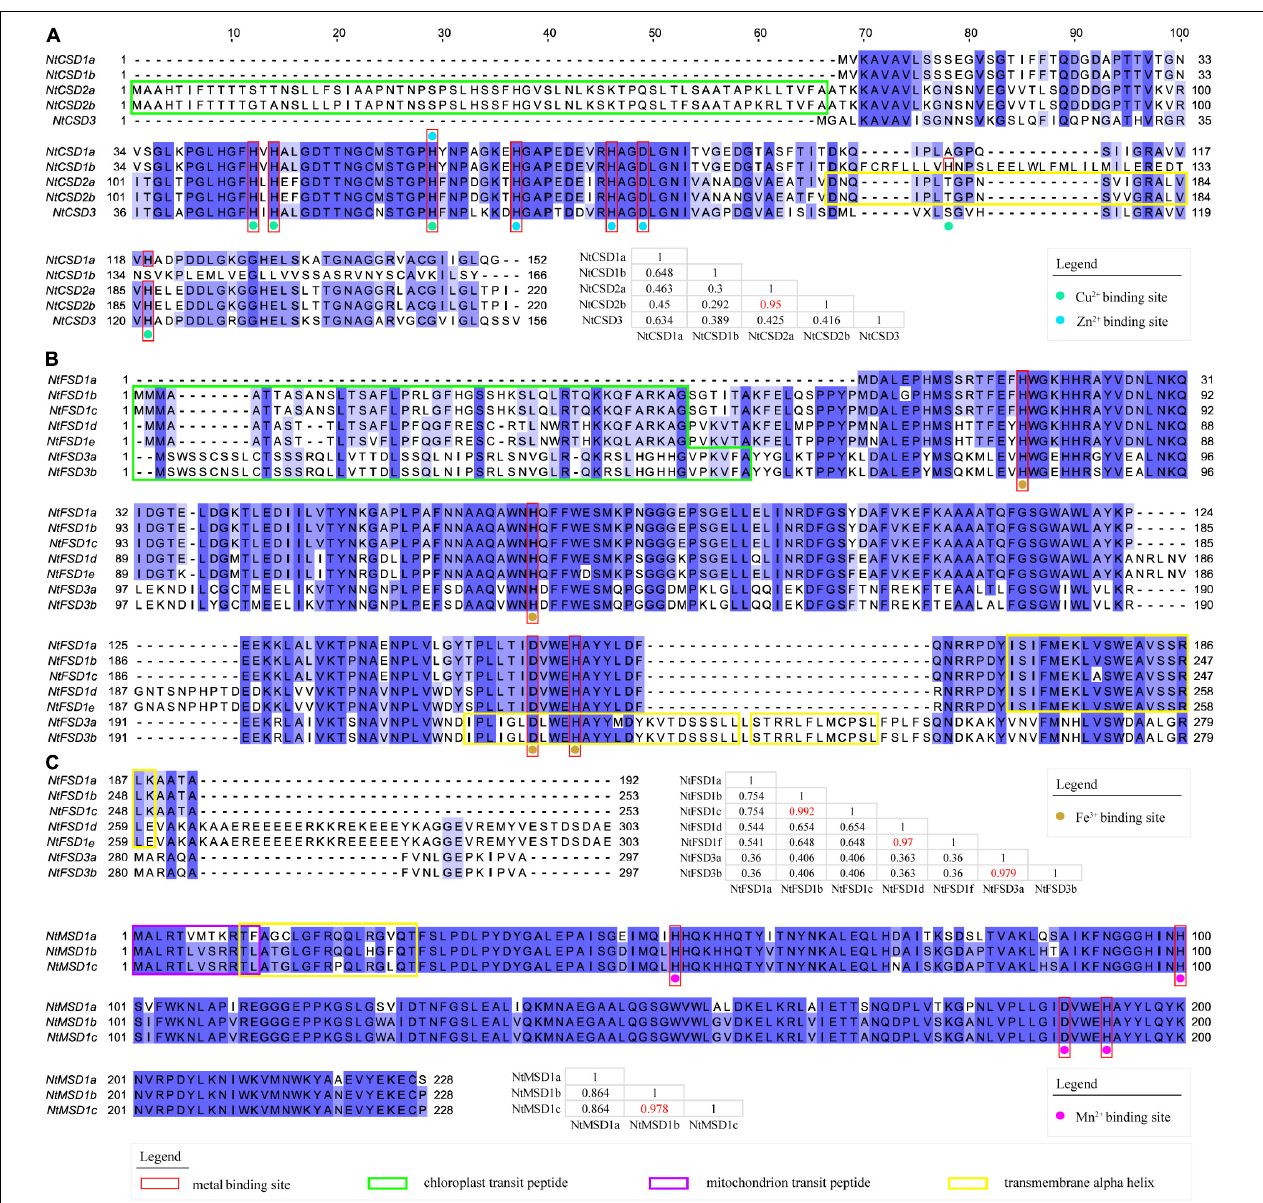
FIGURE 2 | Multiple sequence alignment of deduced amino acid sequences of NtSOD proteins. (A) Multiple sequence alignment of NtCSD proteins. The metal-binding sites for Cu 2 + and Zn 2 + are marked with green and blue dots, respectively. (B) Multiple sequence alignment of NtFSD proteins. Metal-binding sites of Fe 3 + are marked with brown dots. (C) Multiple sequence alignment of NtMSD proteins. Metal-binding sites of Mn 2 + are marked with purple dots. The similarity between amino acid sequences was recorded in the table, and the chloroplast transit peptide, mitochondrial transit peptide, and membrane transit peptide are marked using green, purple and yellow boxes, respectively, and red boxes mark the metal-binding sites of these SOD